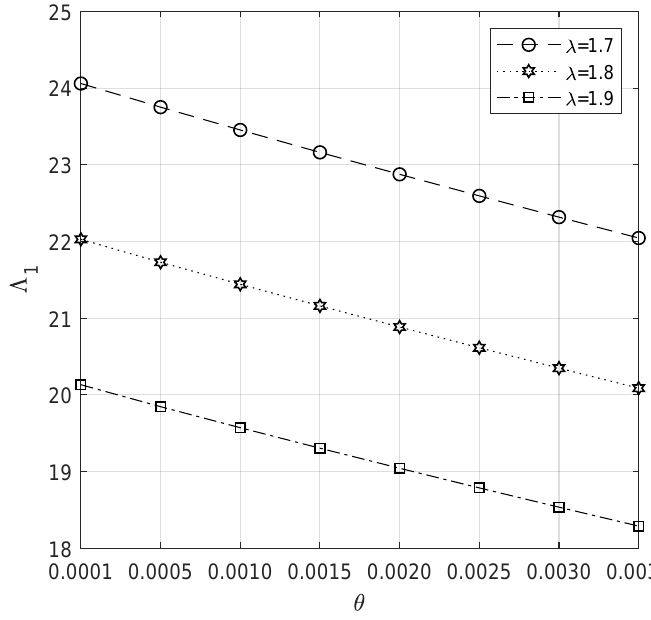
Figure 10. The impact of mean inventory level when λ vs. θ